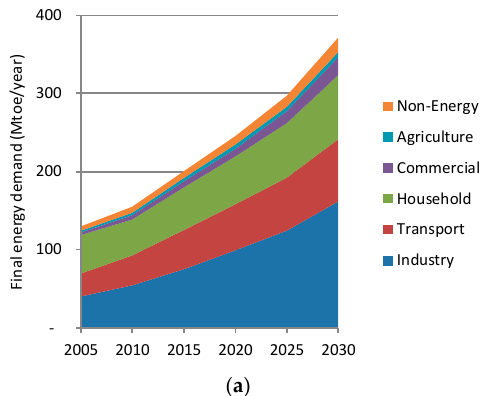
Figure 4. Total energy demand in the baseline scenario. ( a ) Total energy demand by sector, baseline; and ( b ) total energy demand by fuel, baseline.